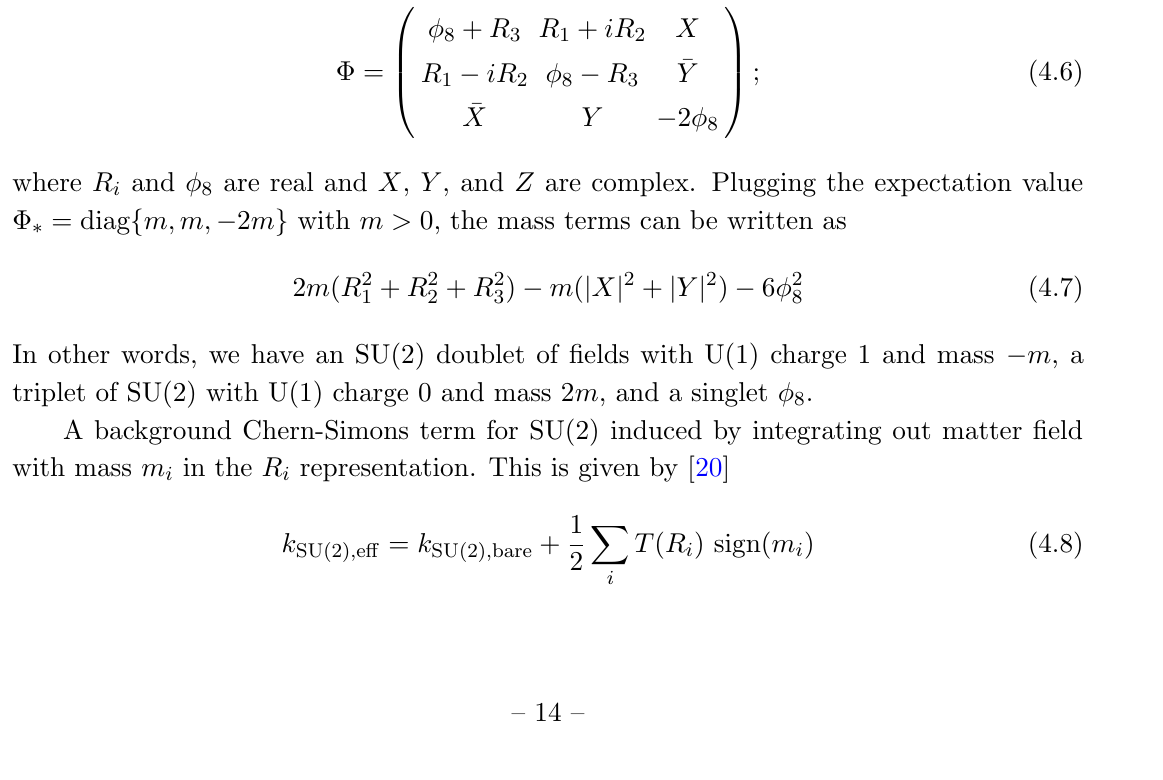
Figure 1 . Phase diagram of the Wess-Zumino model and gauge theory. For the Wess-Zumino model, this is ( M 11 , M 22 ) plane and three half lines are given by L 1 : M 11 L 2 : 2 M 11 + M 22 = 0 ( M 11 < 0), and L 3 : M 11 + 2 M 22 = 0 ( M 11 > 0). For the gauge theory this is ( t , m f ) plane and three lines are given by L 1 : m f = 0 ( t > 0), L 2 : t + m f = 0 ( m f > 0), L 3 : t m f = 0 ( m f < 0). On the three solid half lines, we have an SU(2) (cid:0) deformation, and CP 1 worth of vacua due to spontaneous symmetry breaking. Otherwise, we have 2 isolated vacua due to time reversal symmetry